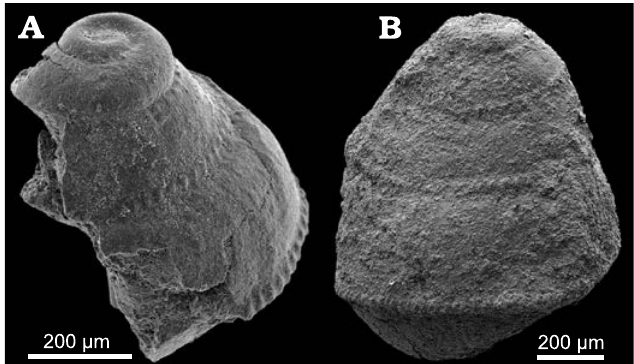
Fig. 18. Zygopleurid larval shells of Zygopleura sp. from Lago Antorno (A) and Misurina Landslide (B), northern Italy, Cassian Formation, Carnian, Upper Triassic. PZO 12836 ( A ) and PZO 12711 ( B ), in lateral